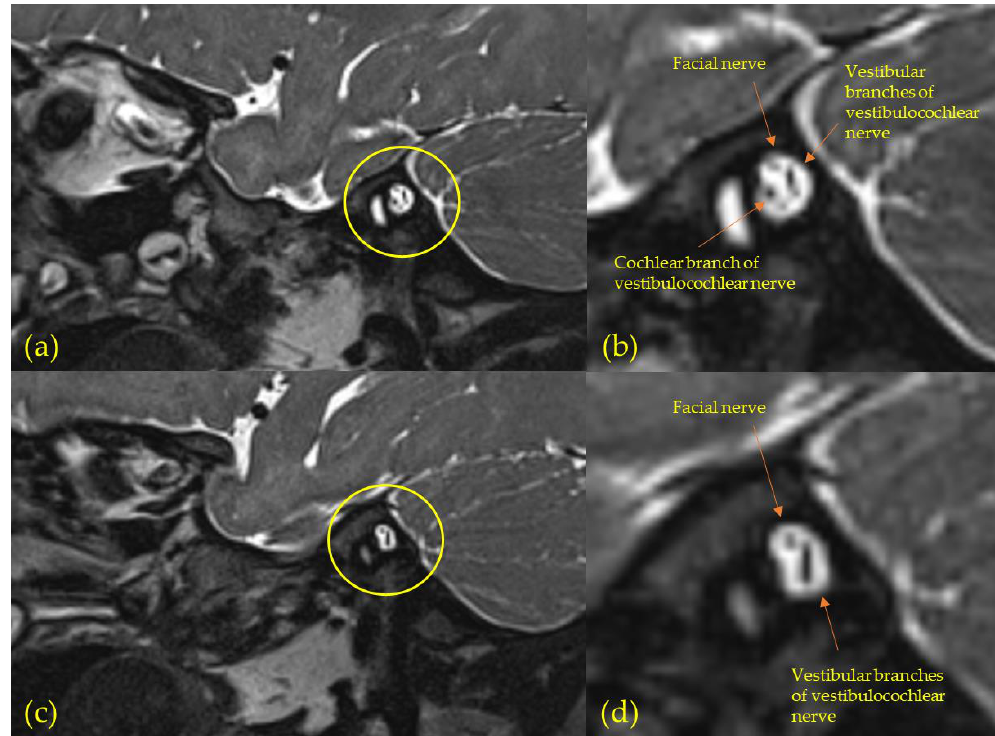
Figure 4. Typical MRI images of the inner auditory canal for subjects with cochlear nerve aplasia (oblique-sagittal view); ( a , b ) The normal-hearing ear (NE) of subject 11 (S11) showing a normal cochlear branch of the vestibucochlear nerve; ( c , d ) The impaired ear (IE) of S11 showing no visible cochlear nerve branch, indicating aplasia or severe hypoplasia.